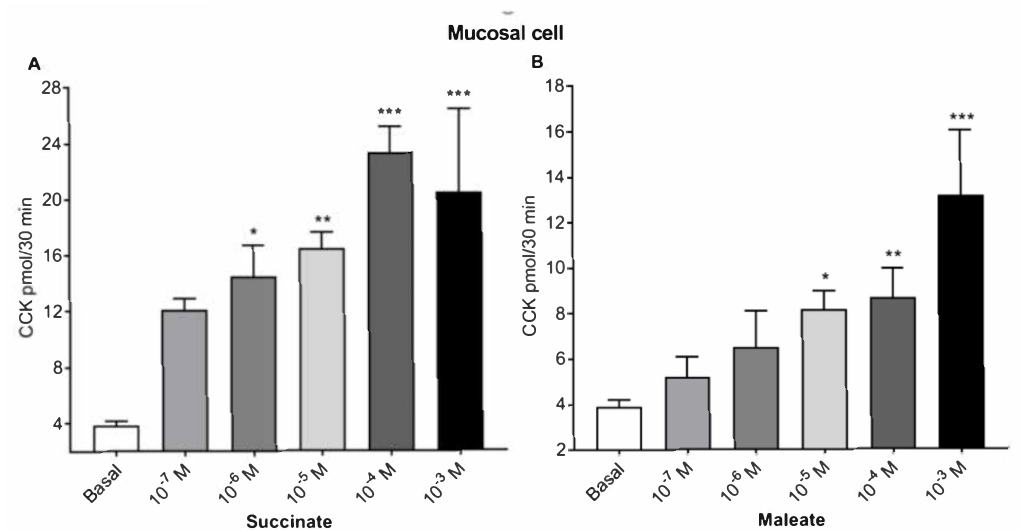
Figure 1. Dose responses of succinate and maleate in duodenal mucosal cells. Cholecystokinin (CCK) release from duodenal mucosal cells by succinate ( A ) and maleate ( B ). Succinate and maleate doses dependently stimulated CCK release from duodenal mucosal cells. CCK was measured in a bioassay and is expressed as a CCK release / 30 min collection period. Results were expressed as mean ± SEM, n = 6. * p < 0.05, ** p < 0.01, *** p < 0.001, compared with basal values.